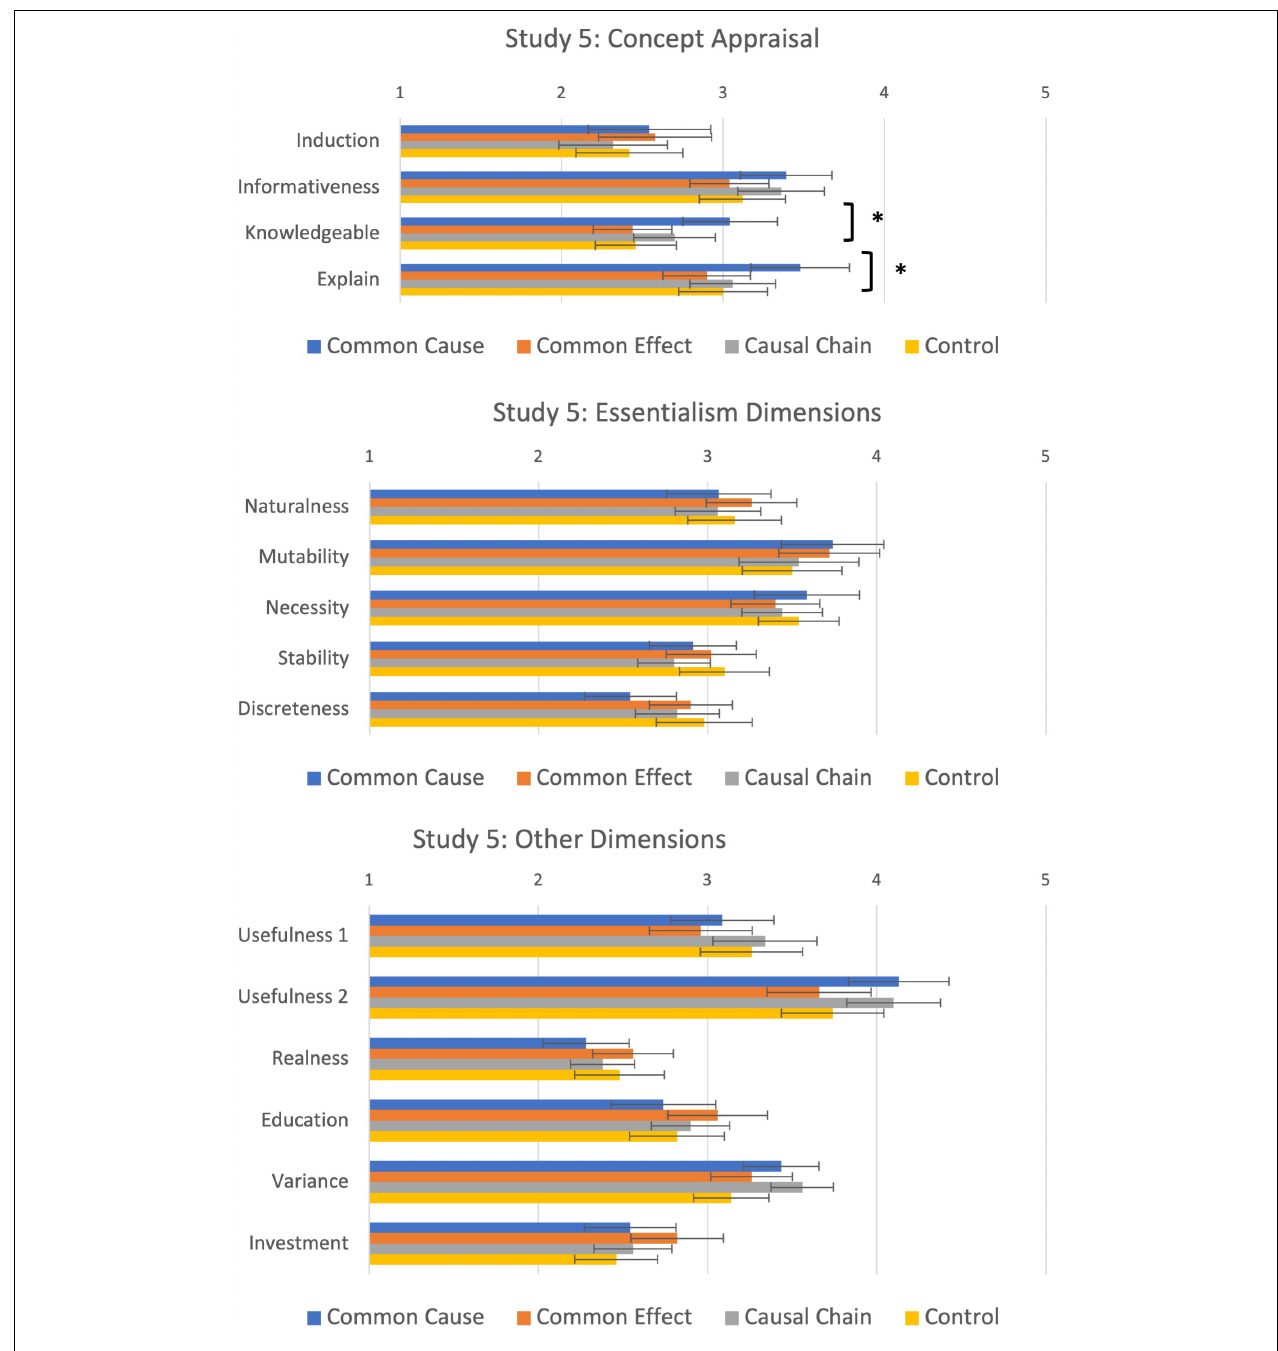
FIGURE 7 | Dimensions of concept appraisal, essentialism and other dimensions as a function of causal condition in Study 5. ∗ Significant at p <